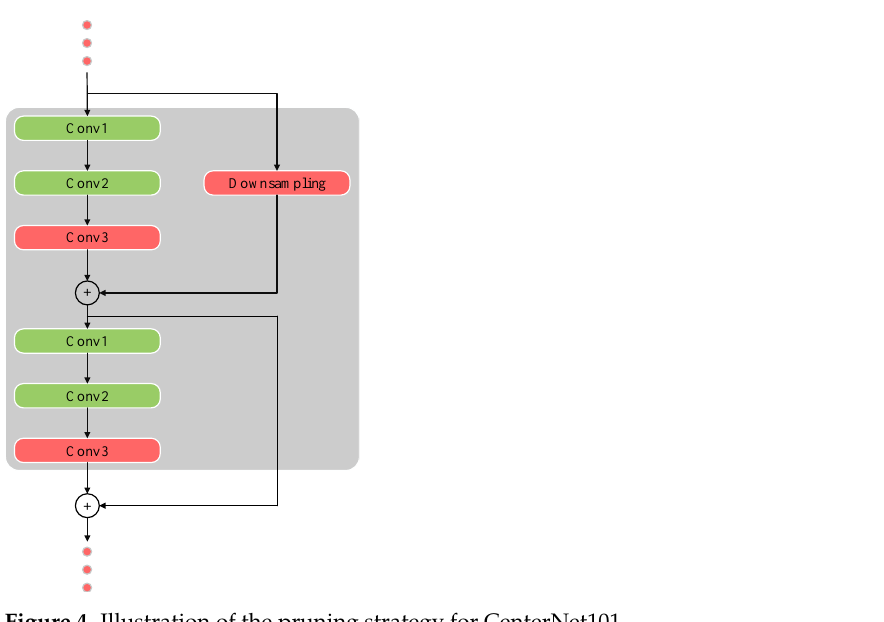
Figure 4. Illustration of the pruning strategy for CenterNet101.